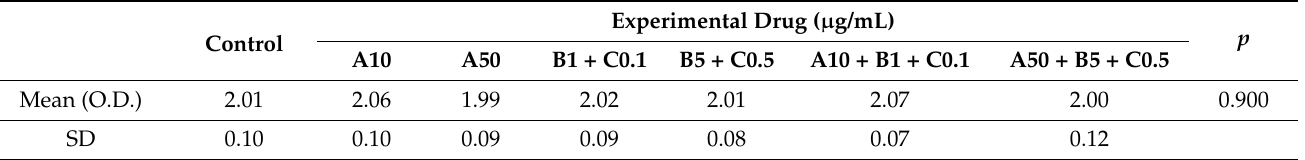
Table 1. Effects of the experimental drugs on the MTT assay of SH-SY5Y cell viability ( n = 5).